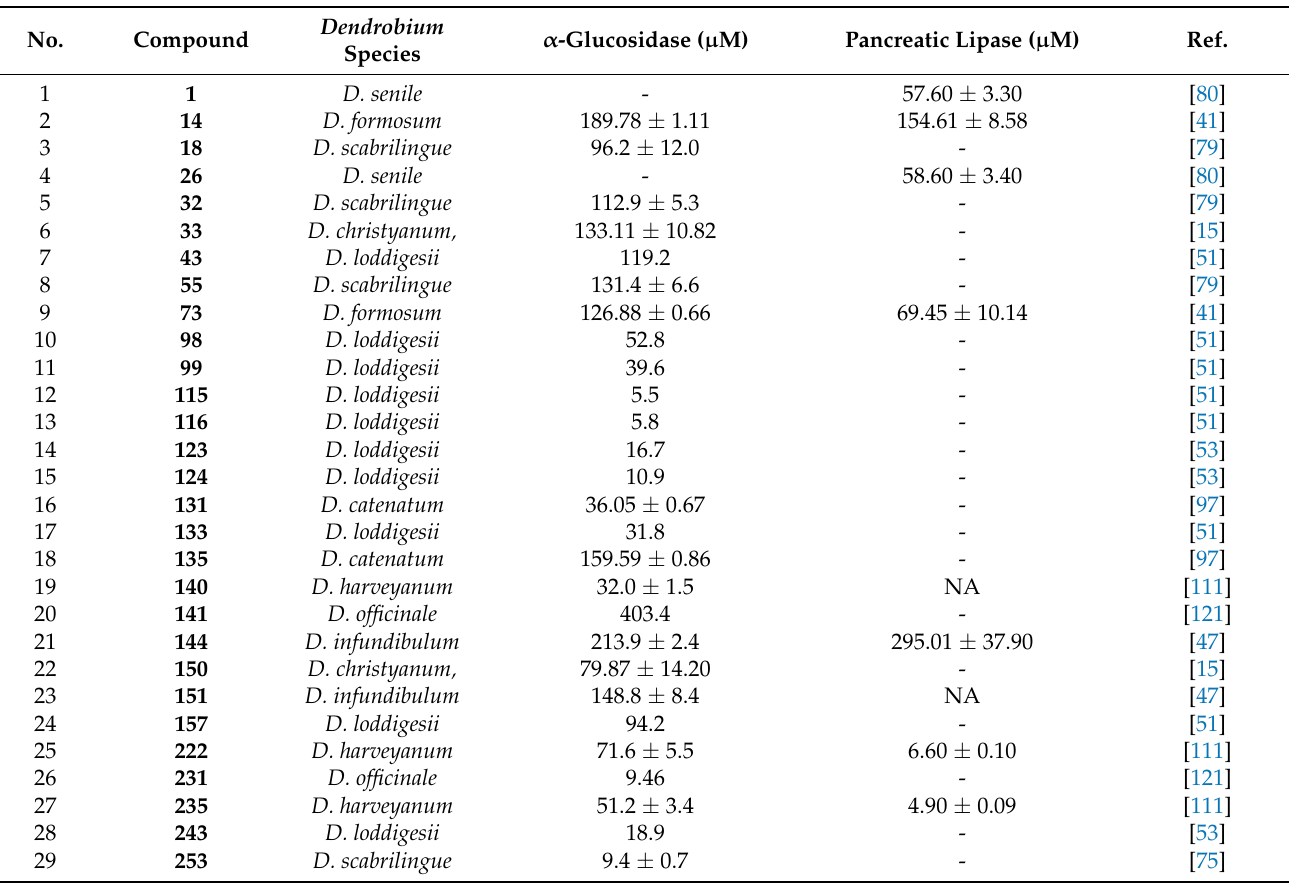
Table 5. IC 50 values of stilbene compounds isolated from Dendrobium genus for α -glucosidase and pancreatic lipase inhibitory